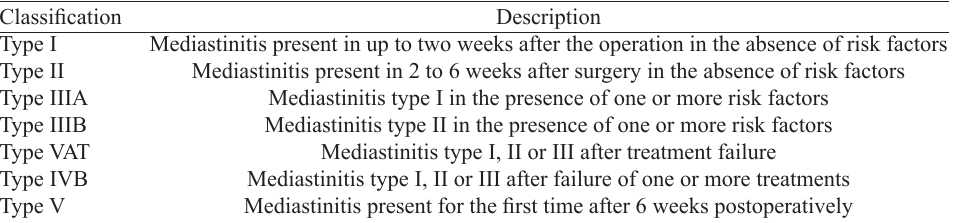
Table 2. Classification reported in 1996 by Oakley, based on postoperative period of the infectious process and the presence of clinical risk factors.